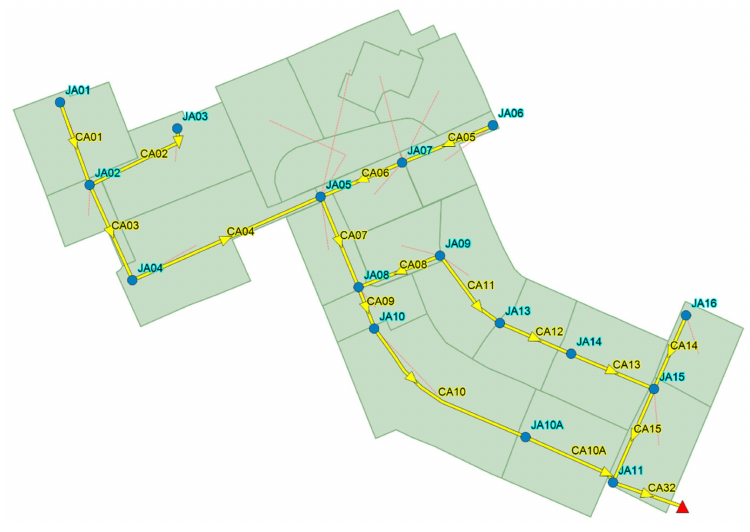
Figure 1. Watershed configuration.